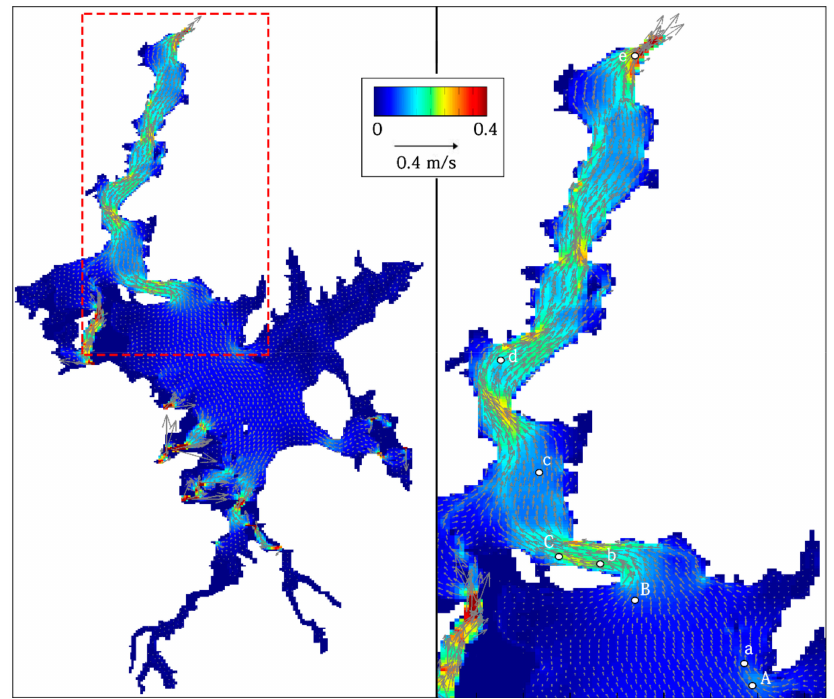
Figure 12. The simulated velocity field in the north of Poyang